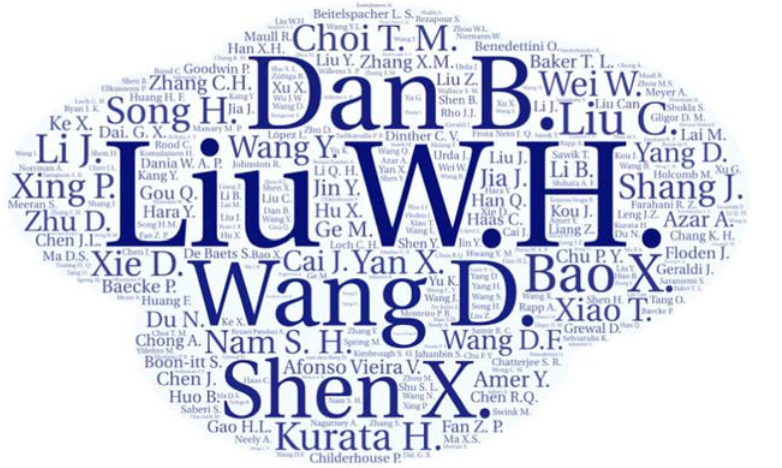
Figure 3. Analysis of